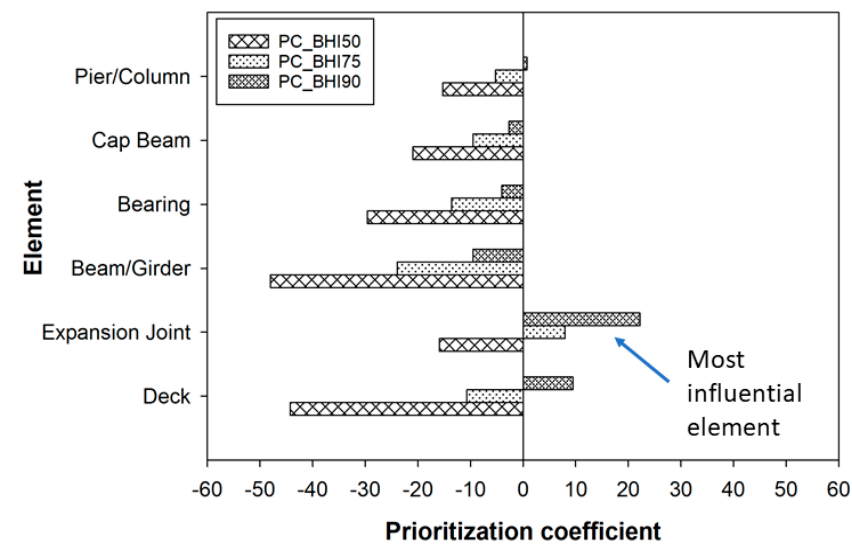
Figure 14. Prioritization coefficients in the ‘PC109’ group for Bridge Health Index (BHI) thresholds (50, 75, and 90). Notes: negative value of ‘PC’ = the element meets the performance level; positive value of ‘PC’ = the element does not meet the performance level.